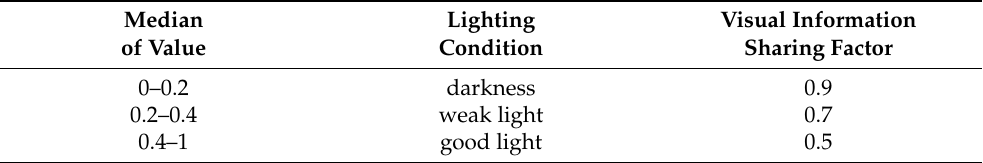
Figure 4. The distribution of value under different lighting conditions, including ( a ) dark, ( b ) dim, ( c ) light in the dark, ( d ) dusk, and ( e ) bright. Table 1. setting of information sharing factor under different